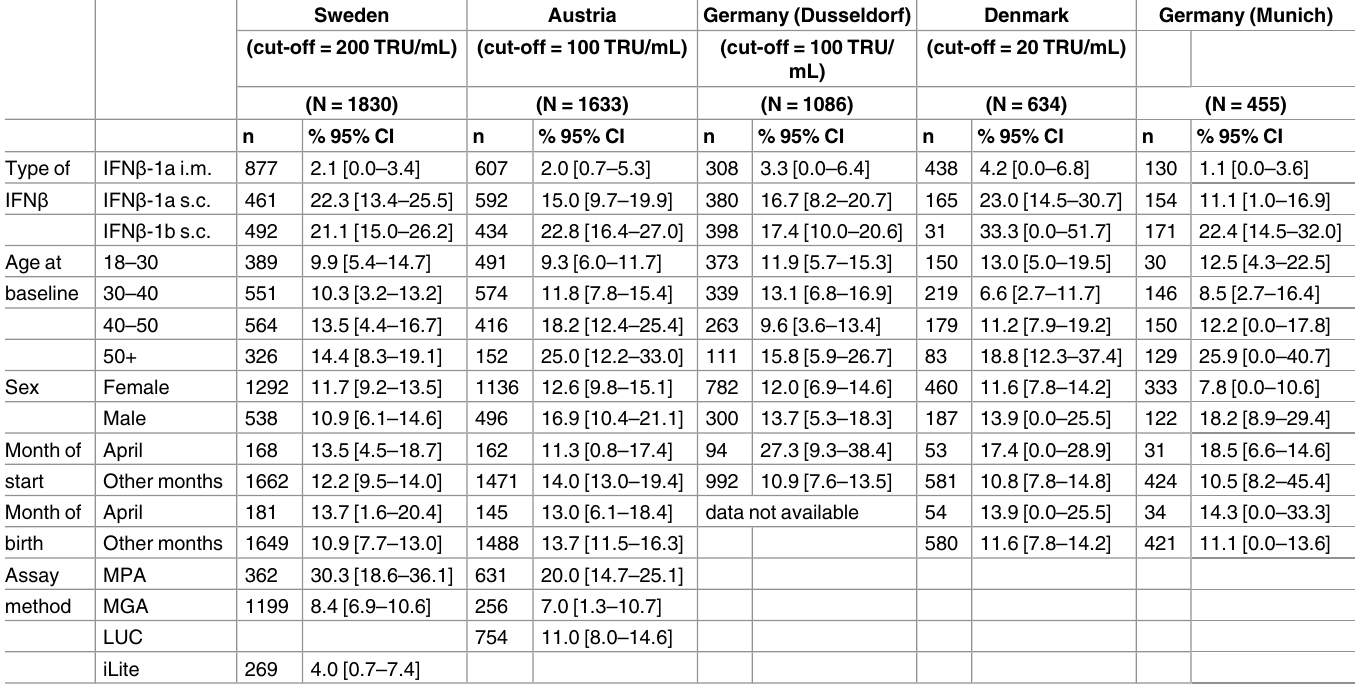
Table 1. Estimated cumulative probabilities with 95% confidence interval of ADA development before 18 months of IFN β